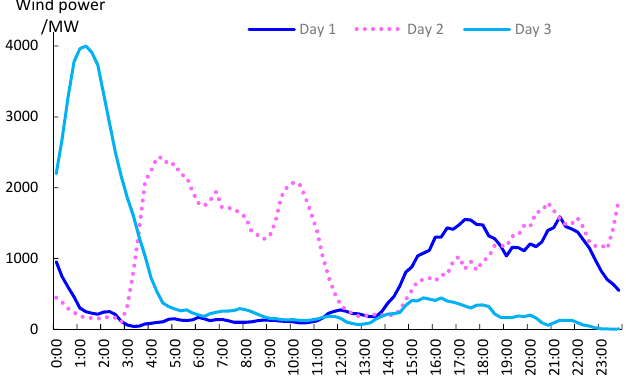
Figure 2. Profile of wind power in Hexi,